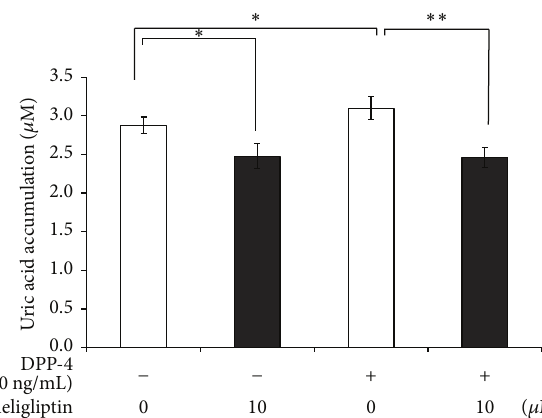
Figure 7: Effects of teneligliptin and DPP-4 on uric acid secretion from 3T3-L1 adipocytes. Serum-starved 3T3-L1 adipocytes were treated without ( ◻ ) or with teneligliptin ( ◼ ; 10 𝜇 M) and/or DPP- 4 (200ng/mL). Uric acid secretion for 24 hours of incubation in the presence of the indicated concentration of teneligliptin or DPP-4, respectively. Data are the means ± SEM of 3 independent experiments (1 experiment performed with 4 samples). ∗ 𝑃 < 0.05 ; ∗∗ 𝑃 < 0.01 versus the value in the absence of